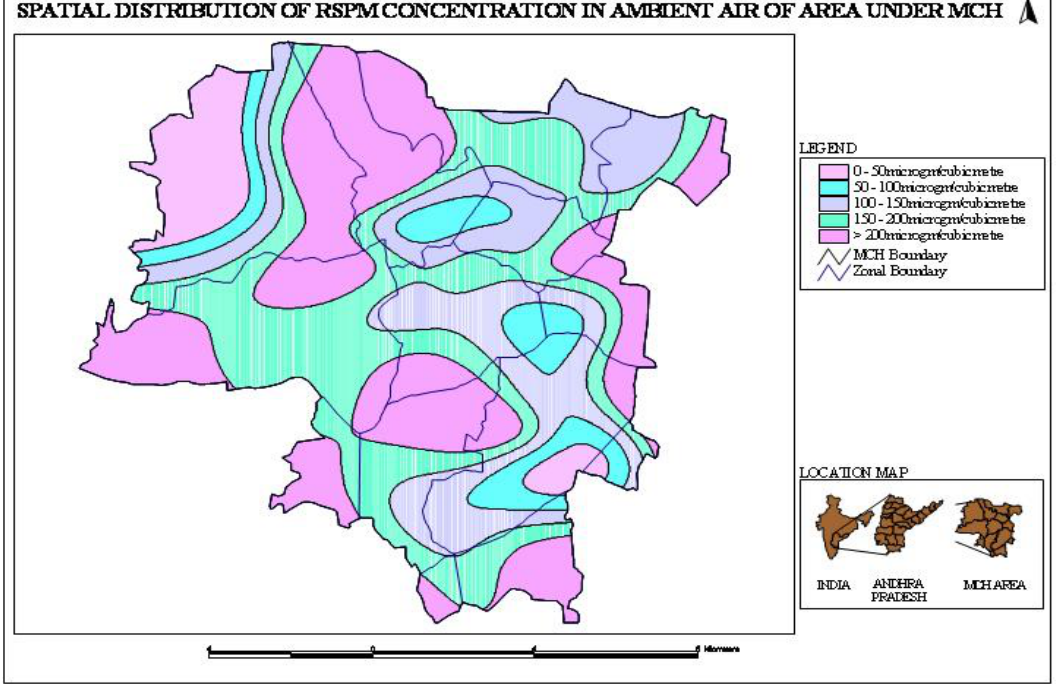
Figure 4: Spatial distribution of RSPM concentration in ambient air of MCH limits